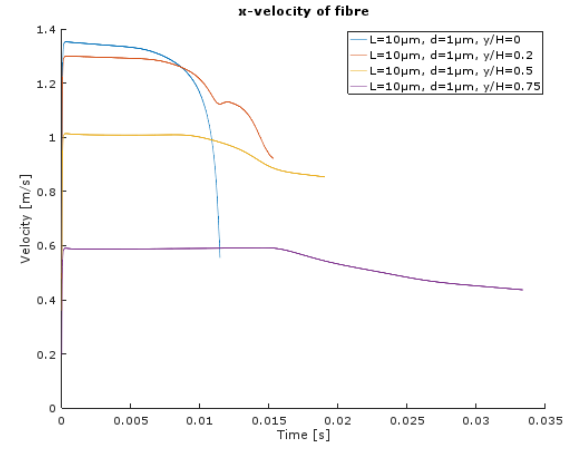
Fig. 6. The x-velocity component of fibre in time .